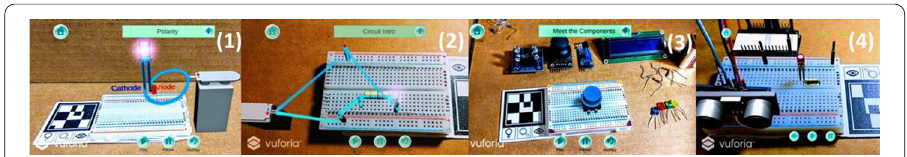
Fig. 6 Overview of microskills: (1) polarity, (2) current flow, (3) components. (4) Interactive example: procedural instructions of ultrasonic sensor control of LED